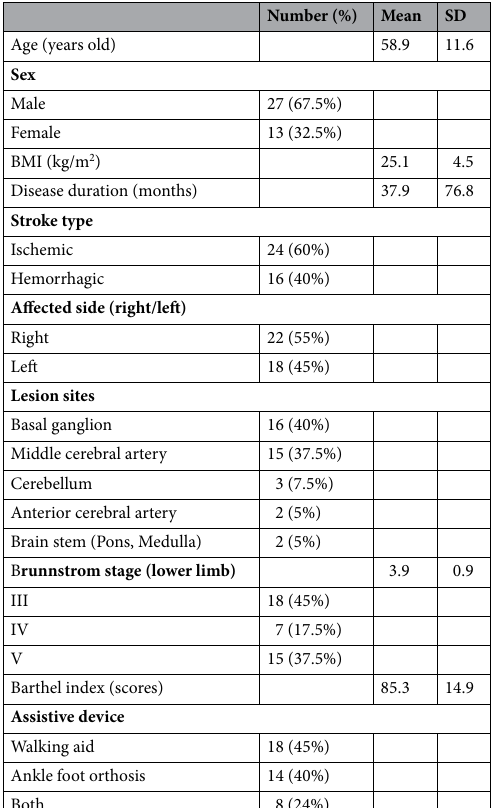
Table 1. Demographic characteristics of the participants. § SD standard deviation; BMI body mass